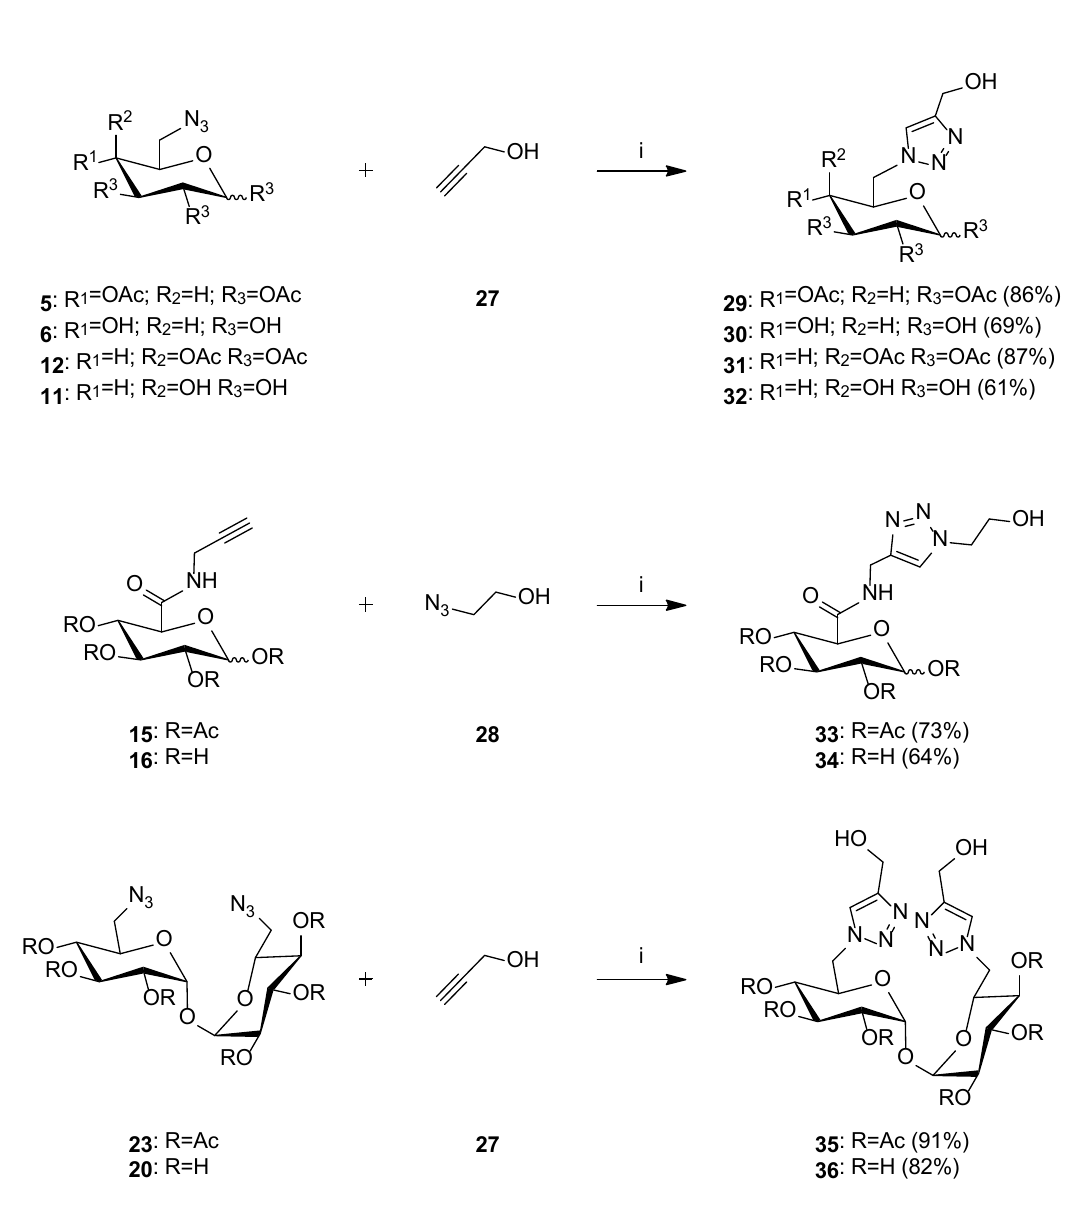
Scheme 9. Synthesis of metabolites of sugar derivatives. Reagents and Conditions: ( i ) CuSO 4 ·5H 2 O, NaAsc, i -PrOH/THF/H 2 O (1:1:1, v : v : v ), r.t., 24